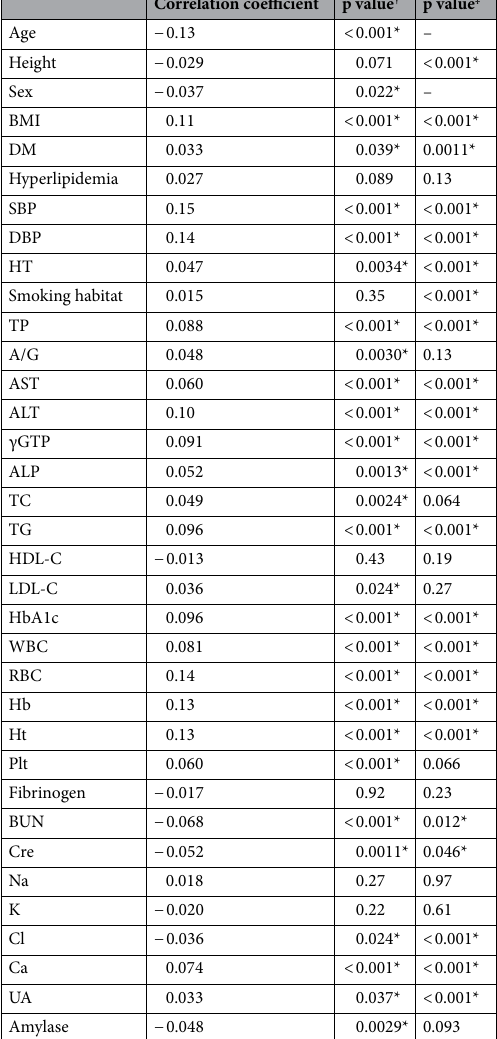
Table 2. Results of univariate analyses between IOP and various systemic parameters. All analyses were performed using Pearson’s rank correlation test. The asterisk (*) indicates p < 0.05. p value † : without adjustment for age, p value ‡ : with adjustment for age. IOP intraocular pressure, BMI body mass index, BP blood pressure, lipoprotein cholesterol, LDL-C low-density lipoprotein cholesterol, HBA1c glycosylated hemoglobin A1c, WBC white blood cell, RBC red blood cell, BUN blood urea nitrogen, Na sodium, K potassium, Cl chlorine, Ca calcium.